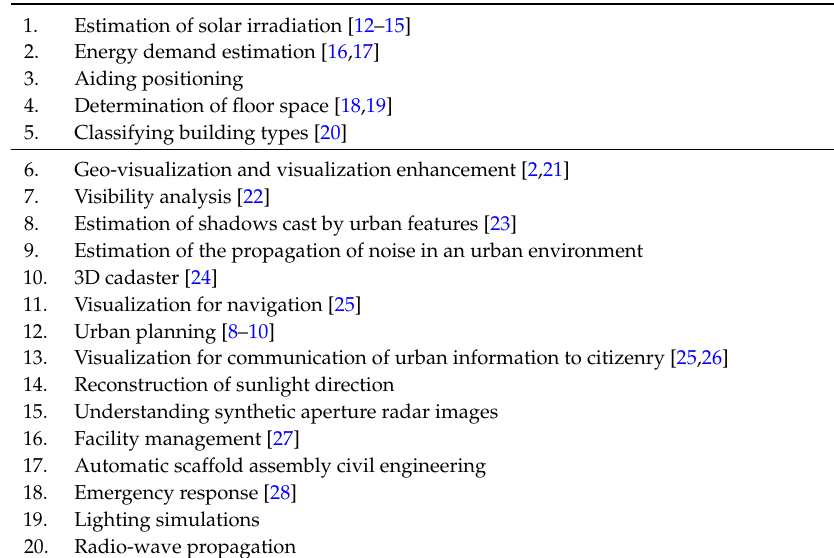
Table 1. Overview of the use cases of 3D city models (adapted from Biljecki et al. [11] ).